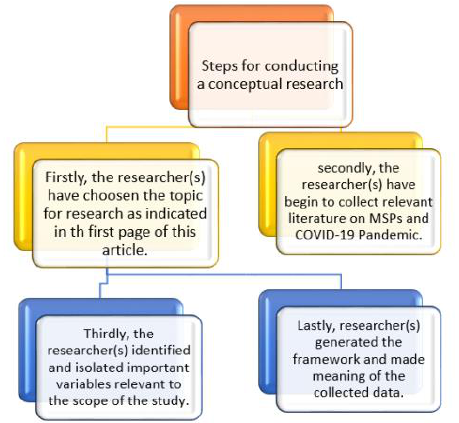
Figure 1: Conceptual Model of the Study ; Source : Mamokhere, Mabeba & Kgobe